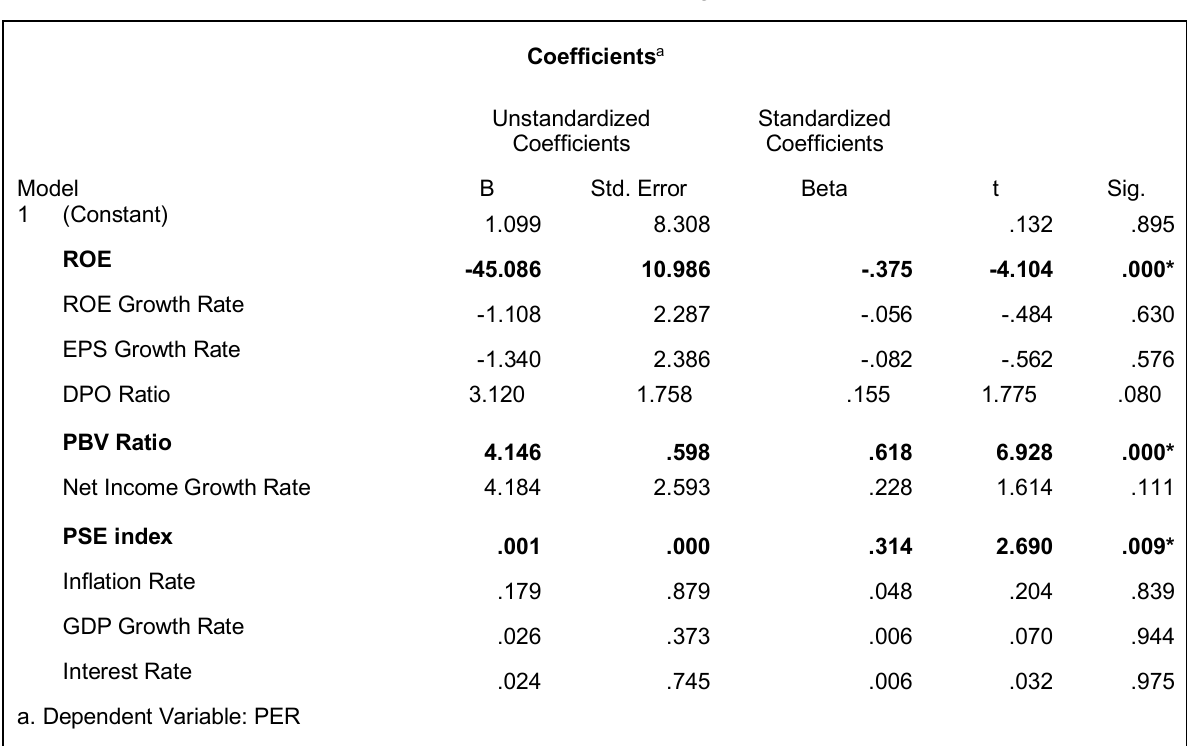
Table 7: Coefficients of